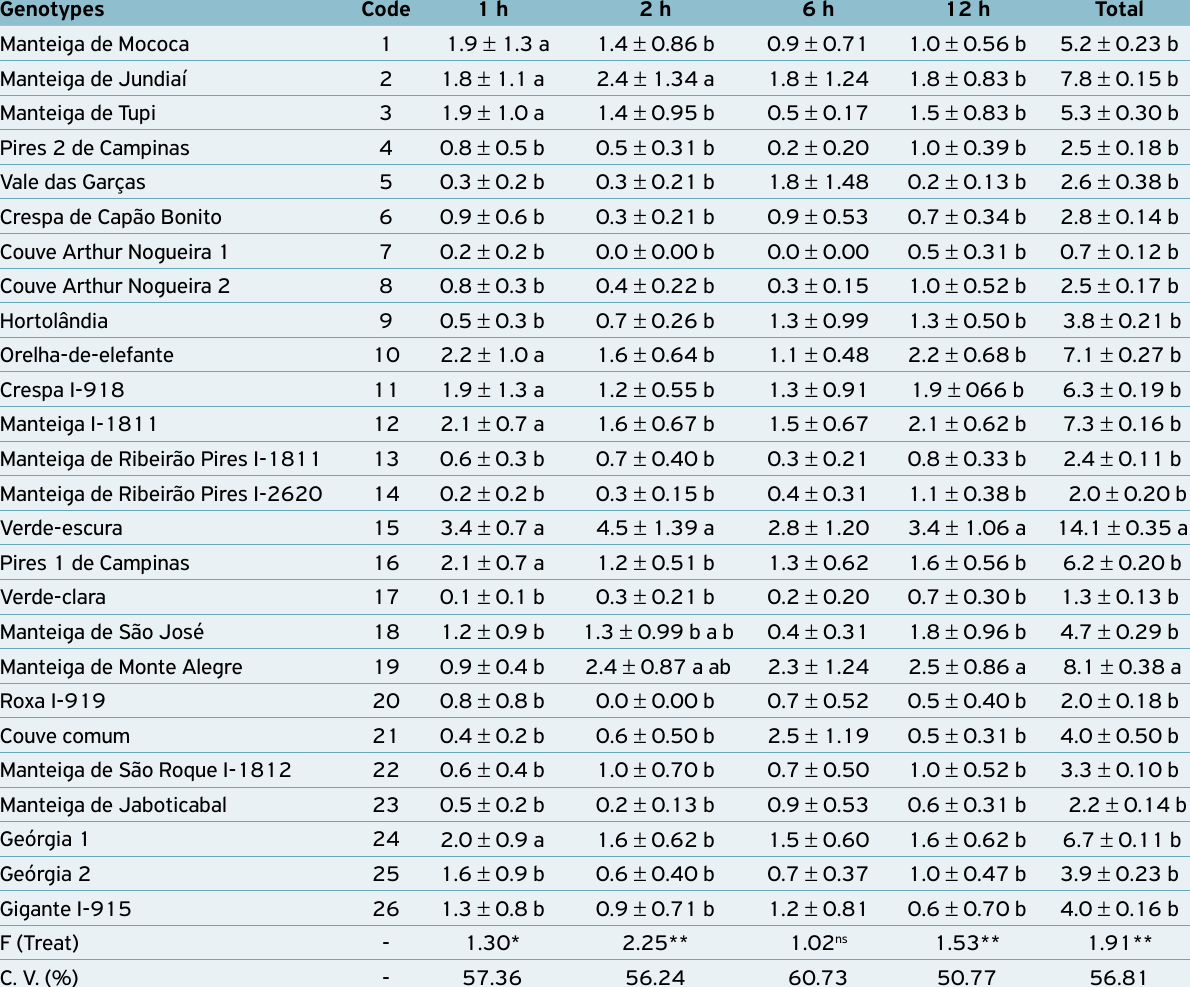
Table 1. Mean number ( ± SE) of third-instar larvae in free-choice test of Ascia monuste orseis in collard greens genotypes